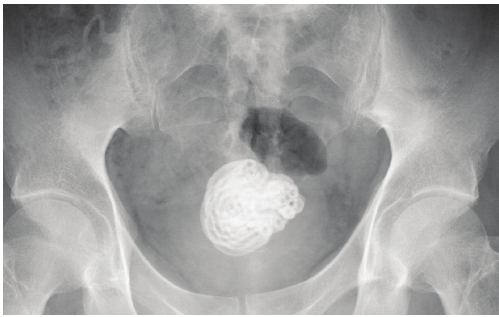
Figure 1: Abdominal plain X-ray showing a convoluted foreign body in the